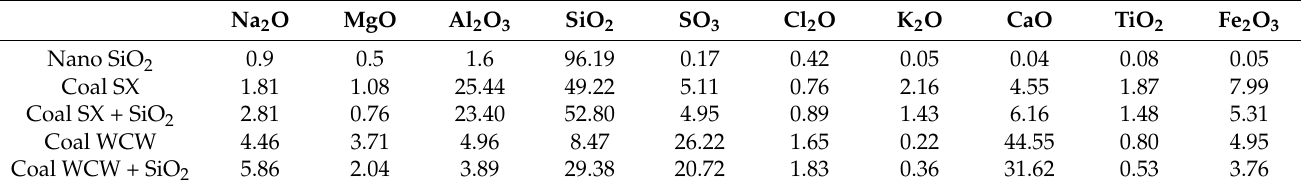
Table 2. Composition of nano SiO 2 particles and the low-temperature ash of coals SX and WCW with/without nano SiO 2 addition